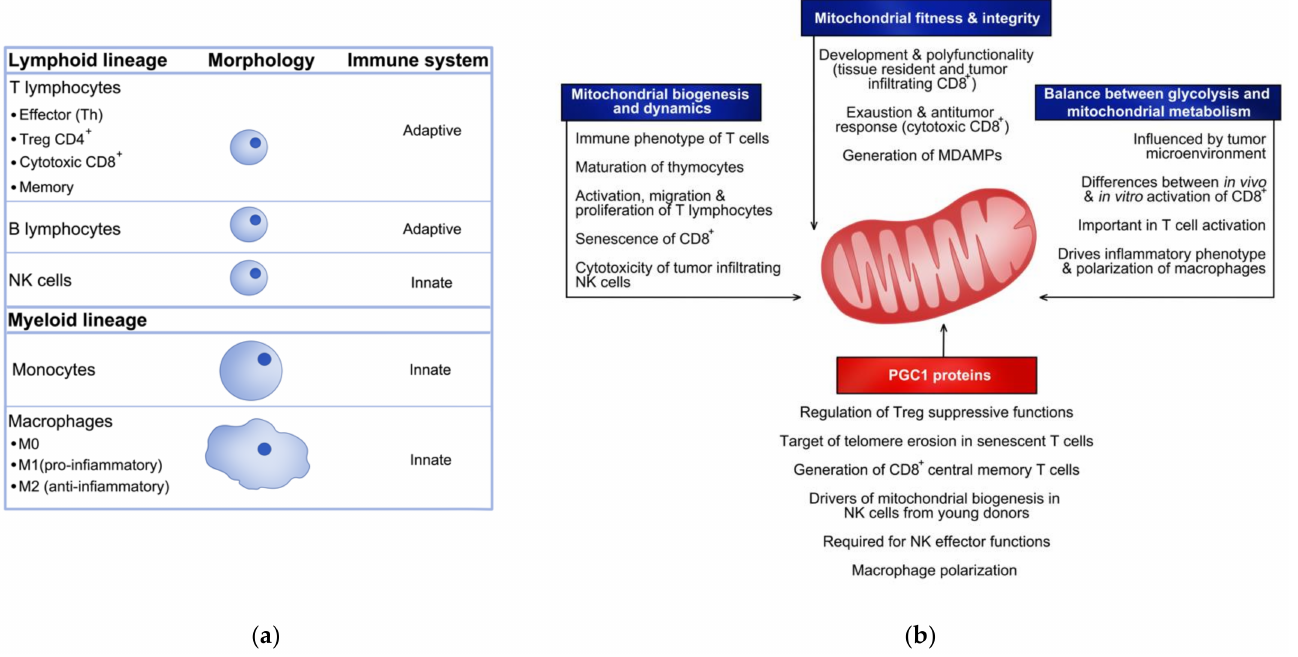
Figure 2. Role of mitochondria and PGC1 proteins in the immune system. Schematic list of the immune cell populations cited in the text ( a ). Summary of functions and phenotypes of different immune cells affected by mitochondrial features and PGC1 proteins ( b